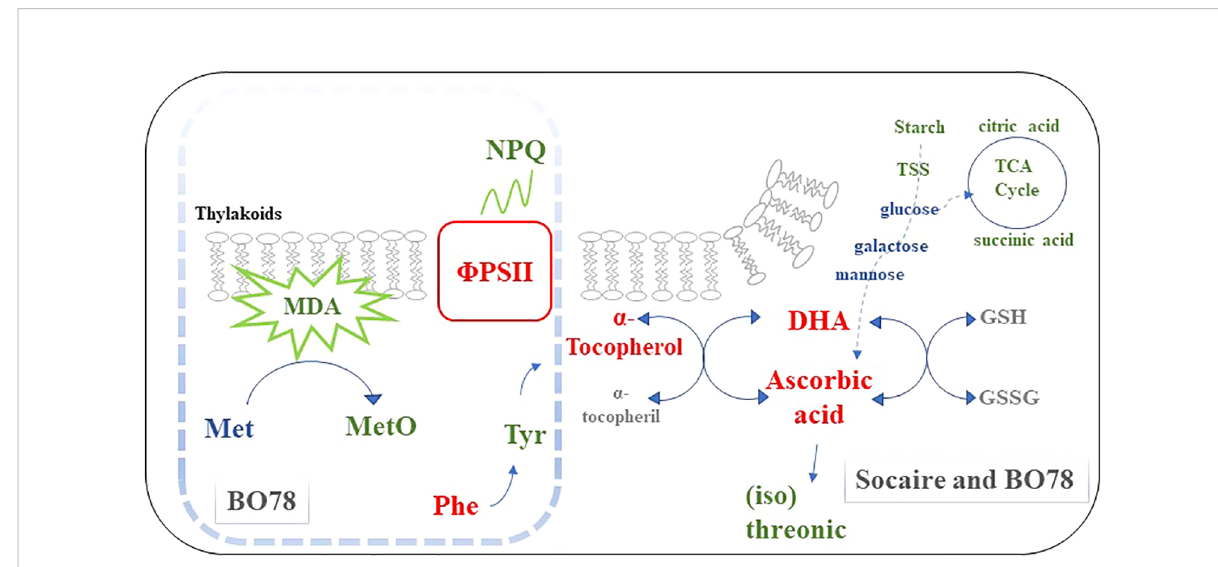
FIGURE 7 Simpli fi ed schematic of seed HP effect on physiological processes and metabolites in C. quinoa ecotypes. Seed HP (as a unique factor) induces a reduction of starch and citric acid, and, in interaction with salinity, reduced TSS and succinic acid; however, seed HP maintains glucose, galactose, and mannose, which are important substrates for ascorbic acid biosynthesis. Seed HP enhanced the level of ascorbic acid, dehydroascorbic (DHA), and a -tocopherol, which are involved in antioxidant cycles associated with stabilize membranes. Additionally, seed HP reduced levels of threonic and isothreonic acids, suggesting that ascorbic acid could be less degraded. It is suggested that the higher level of a - tocopherol contributes to this response. The enhanced aromatic amino acids pathways (Phe and Tyr) observed in BO78 have been pointed out as an alternative pathway to produce a -tocopherol. Finally, the level of oxidative markers (methionine sulfoxide and MDA) (that increases under saline conditions) was reduced by the effect of seed HP, and further reductions were observed in the most sensitive than in the tolerant ecotype. We suggest that these changes might increase the robustness of PSII through an increase of F PSII and a decrease of NPQ, which was observed in the most sensitive ecotype (BO78). Red, green, and blue colors represent an increase, reduction, or non-change in the physiological process or metabolite accumulation upon HP (compared to UP) or HP-S (compared to UP-S treatment), respectively. The gray color represents metabolites that were not present (or not identi fi ed) in the metabolome pro fi ling. The processes and metabolites inside the square dotted line correspond to changes only in the BO78